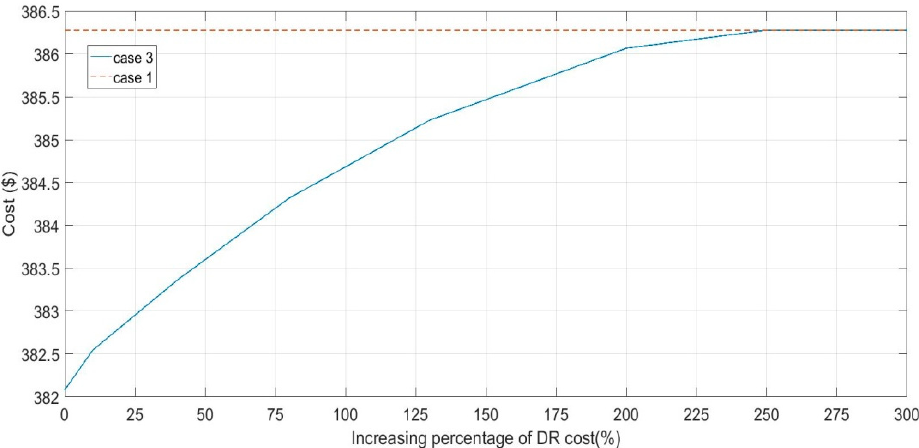
Figure 8. Sensitivity analysis of the cost of the demand response.